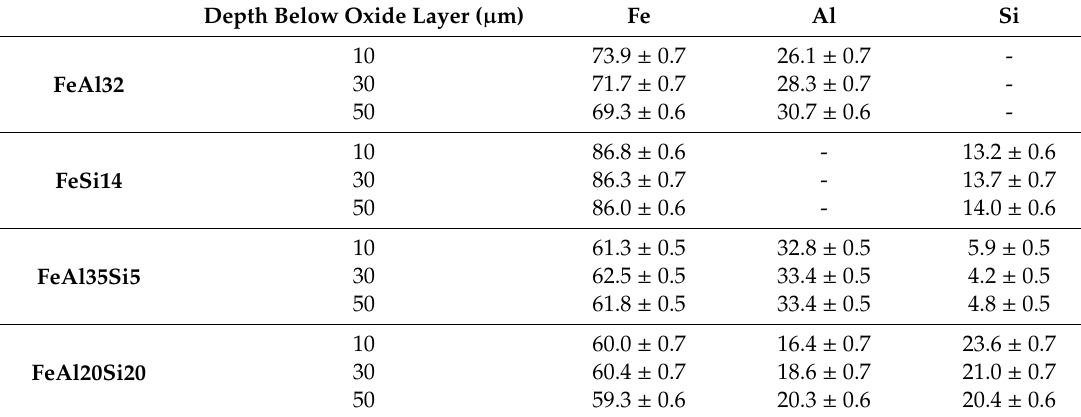
Table 4. Chemical composition of the material below the oxide layer after 300 h of oxidation at 800 ◦ C (in wt %, EDS).